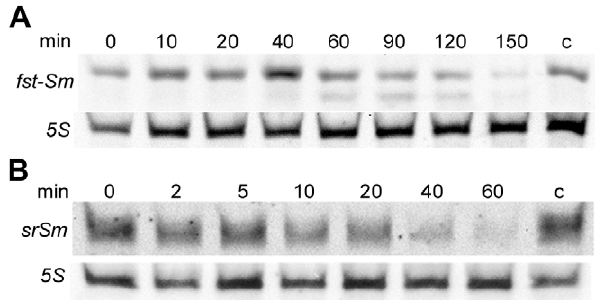
Figure 3. RNA half-life determination. Stability of fst-Sm mRNA ( A ) and srSm RNA ( B ) by Northern blot analysis. Total RNA was extracted from WT mid-log cells at the indicated times after addition of 300 m g/ml rifampicin. Time points of sampling are indicated above each lane. Biotin-labeled DNA probes were used for RNA detection. The probing for 5S RNA confirmed equal loading. Control RNA extraction represents total RNA extracted from cells cultivated without rifampicin at time- point 150-min ( fst - Sm mRNA detection) and 60-min ( srSm RNA detection). Blots shown represent results from three experiments.